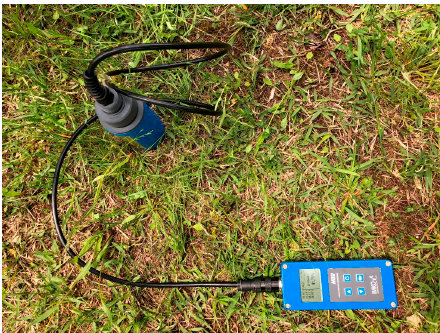
Figure 2. Time-domain reflectometry (TDR) measurements of the soil moisture for the estimation of the subsurface velocity in the site.